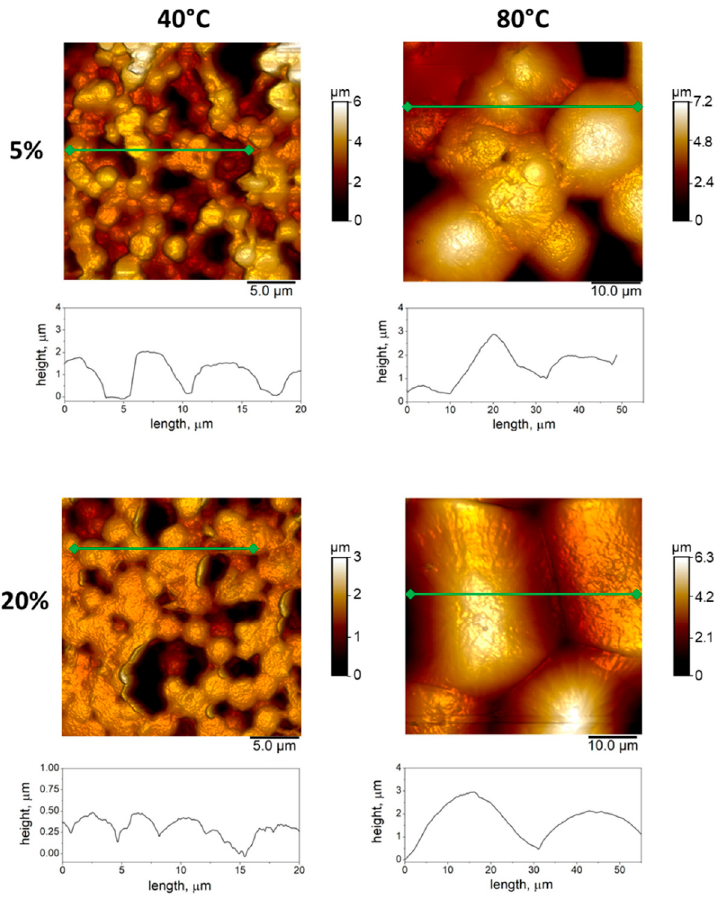
Figure 2. Quantitative analysis of surface morphology via AFM: images collected from samples with different polymer concentration (i.e., 5 and 20%) and treated by different casting temperature (i.e., 40 and 80 °C). Below the images, the profiles at the micrometric scale corresponding to the green cross-section lines were reported.